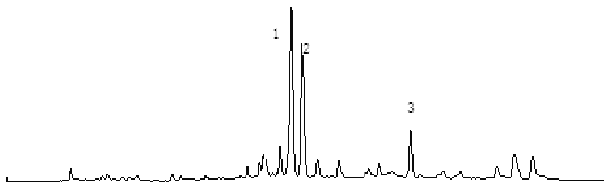
Fig. 2. HPLC chromatogram of Lonicerae Japonicae Flos solution extracted by water under optimized conditions. The peaks marked 1, 2 and 3 are secologanic acid, chlorogenic acid and galuteolin, respectively.